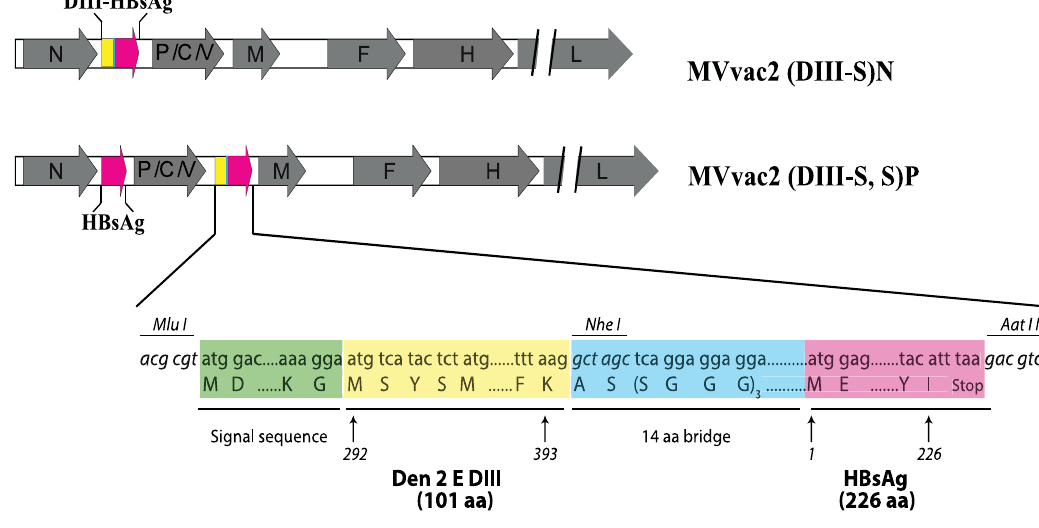
Figure 1. Schematic representation of recombinant measles vectors expressing hybrid HBsAg glycoprotein antigens. Gray arrows represent the MV cistrons, while colored arrows represent the HBsAg or its recombinant hybrid derivate coding sequences. In the lower panel, an abbreviation of the inserted sequence is shown (colored boxes with aa abbreviations are not drawn to scale); important restriction sites (italics) and the relevant amino acid sequence and positions for the signal sequence of the immunoglobulin light chain, Dengue 2 Envelope glycoprotein domain III (aa 292–393), the protein bridge and HBsAg (aa 1–226) sequence are